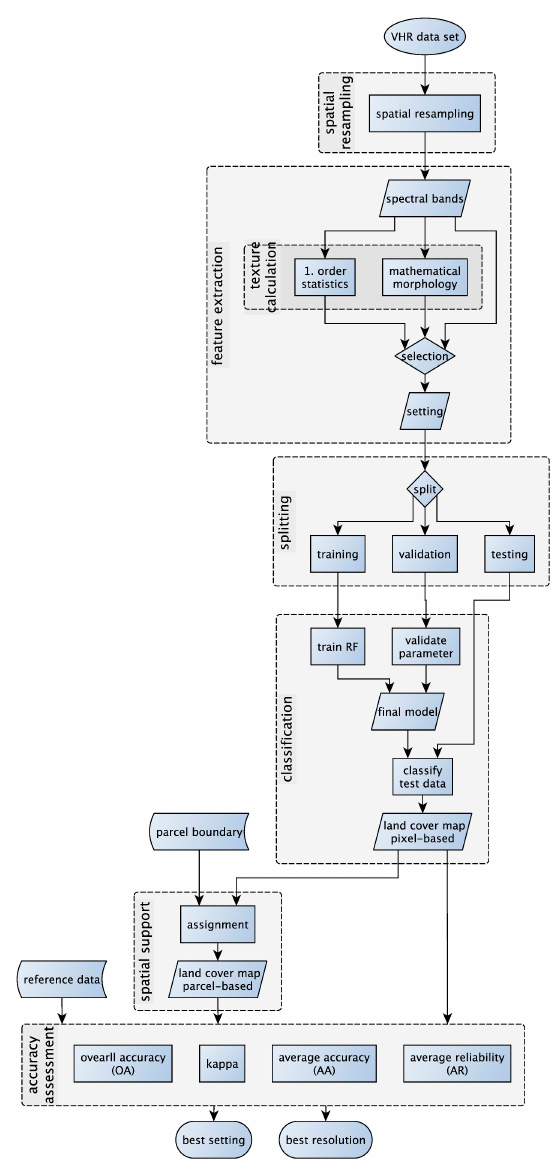
Figure 3. Flowchart of the